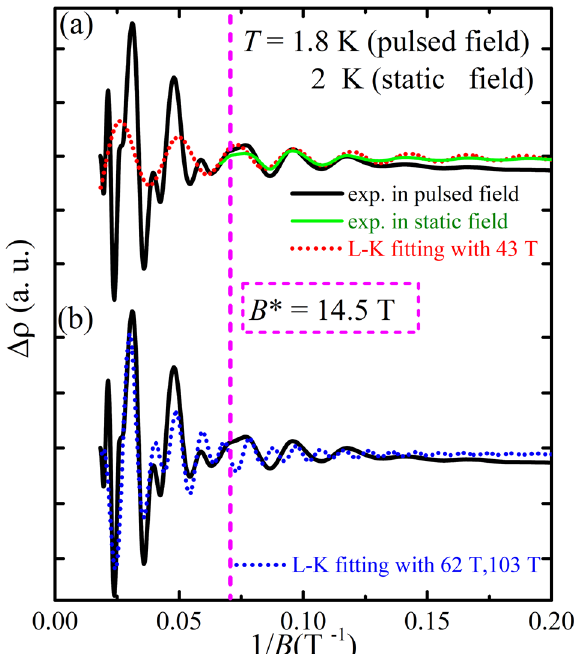
Fig. 3 The Lifshitz – Kosevich fi t to Δ ρ ( B ) measured with the pulsed fi eld. Inverse fi eld dependence of the oscillatory magnetoresistance measured at 1.8 K with pulsed- fi eld and at 2 K with static fi eld are depicted as black and green lines, respectively. Note that the L – K fi tting with a single frequency of 43 T reproduces the SdH oscillations nicely for the fi eld below B * , but fails for B > B * , as shown in panel ( a ). A multi-frequency L – K fi tting by employing both F 2 and F 3 describes Δ ρ ( B ) reasonably well for B > B * , seeing panel ( b ).